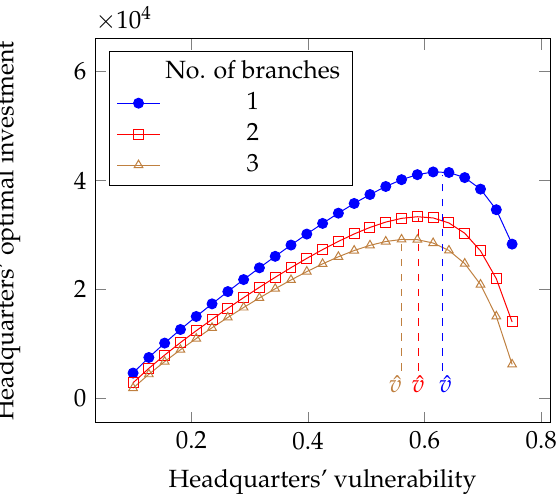
Figure 7. Impact of the intrinsic vulnerability on the optimal investment in security in the full liability